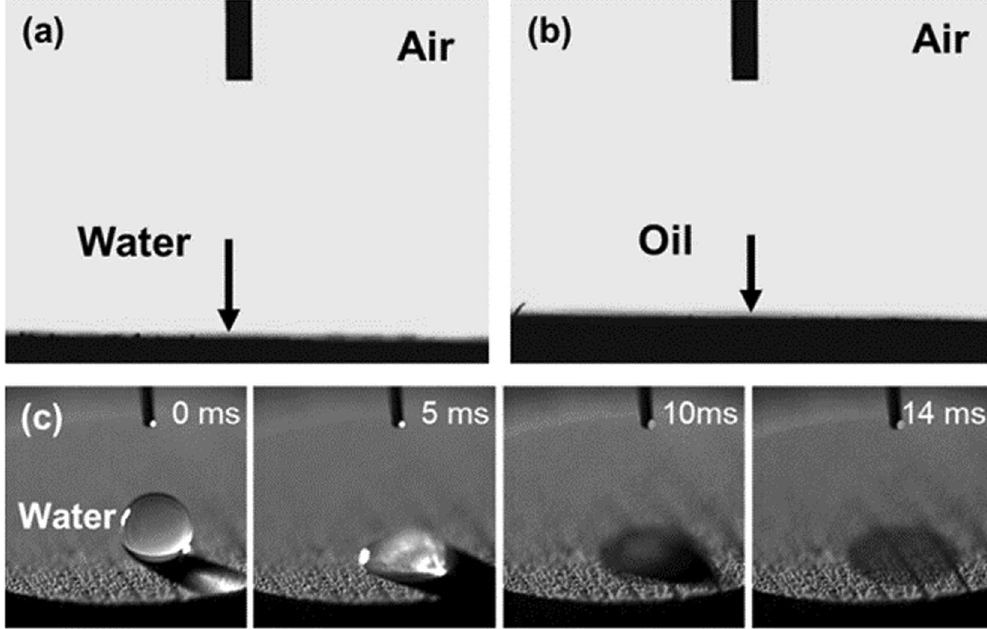
Figure 2. The contact angles of ( a ) water and ( b ) oil on the hierarchical porous membrane (cooling rate: 5 °C min − 1 ). ( c ) Still images captured from a video showing a water droplet penetrates into the membrane within 14